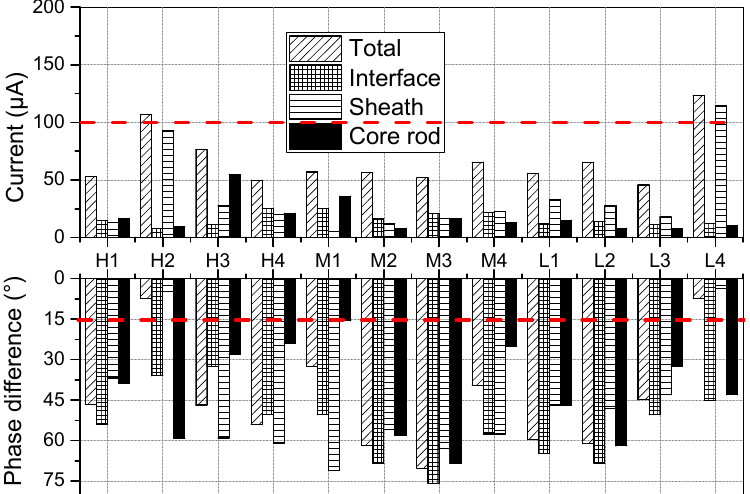
Figure 18. Results of the voltage test after 100h water diffusion test